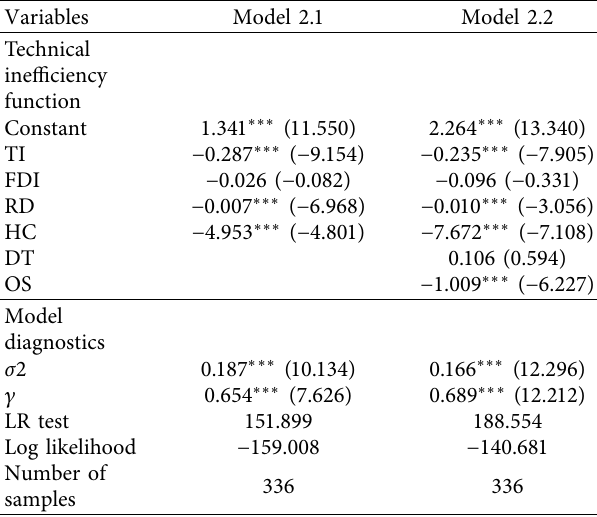
Table 6: Estimation results without considering environmental Table 5: Robustness test